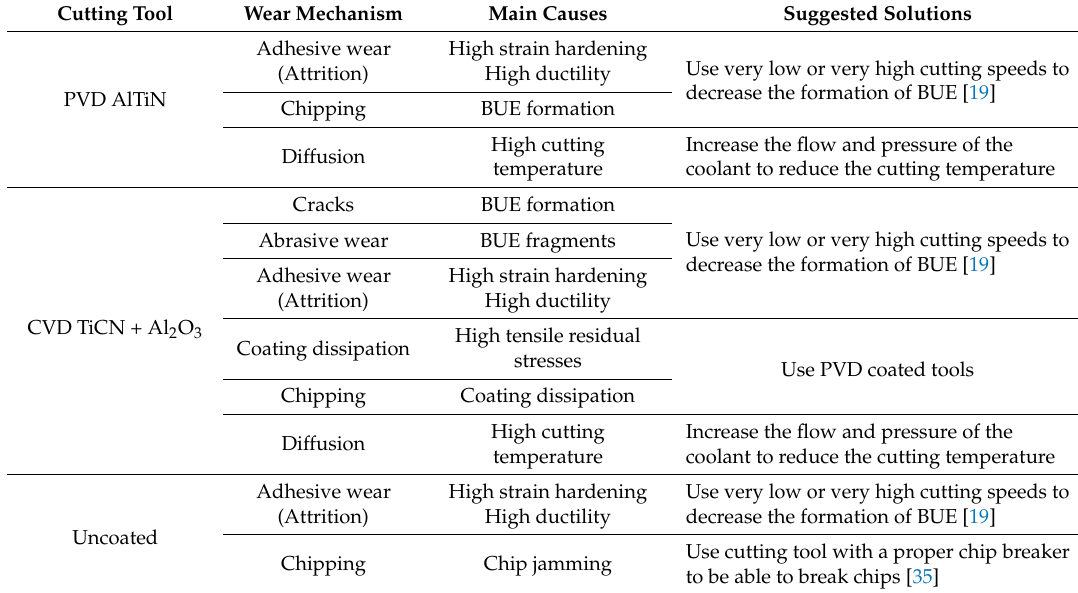
Table 5. A summary of the main causes and suggested solutions of different wear mechanisms observed for uncoated and coated